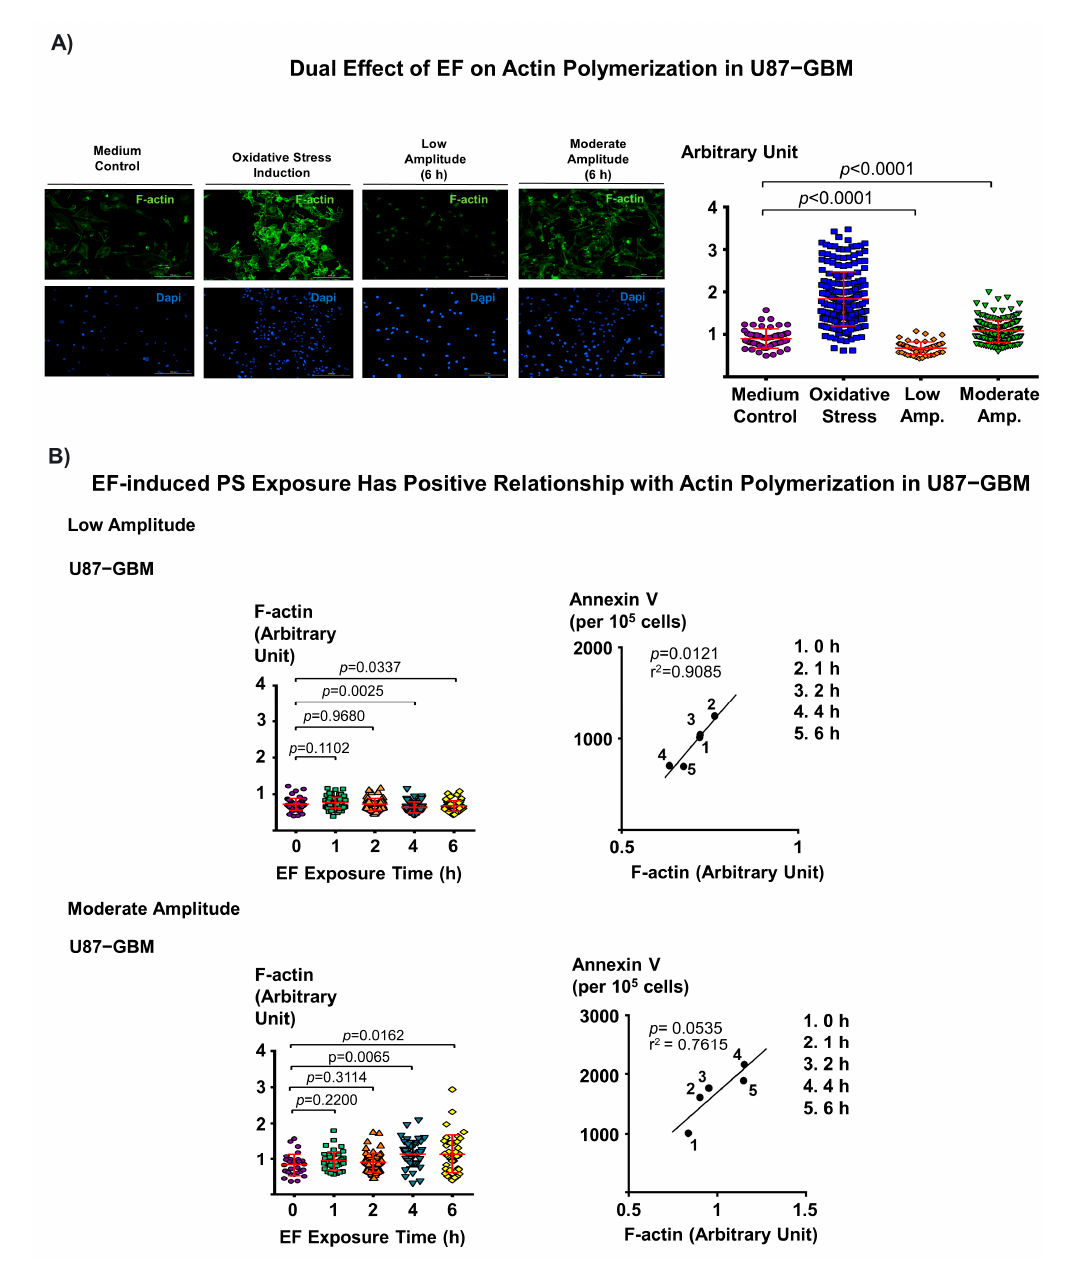
Figure 4. Actin polymerization is involved in the regulation of EF - induced PS externalization in cancer cells. ( A ) Representative immunofluorescence images of glioblastoma cells (U87-GBM; per 10 5 cells) (left panel) demonstrating that low-amplitude EF stimulation decreases actin polymerization, while moderate-amplitude EF stimulation increases actin polymerization levels in cancer cells. Negative control: culture medium; positive control: oxidative stress induction with 1.2 mM H 2 O 2 for 20 min. ( B ) There is a trend toward a positive relationship between F-actin and PS exposure of cancer cells in both low and moderate amplitude EF stimulation groups (r 2 = 0.9085, p = 0.0121 vs. r 2 = 0.7615, p = 0.0535, low vs. moderate amplitude, respectively).